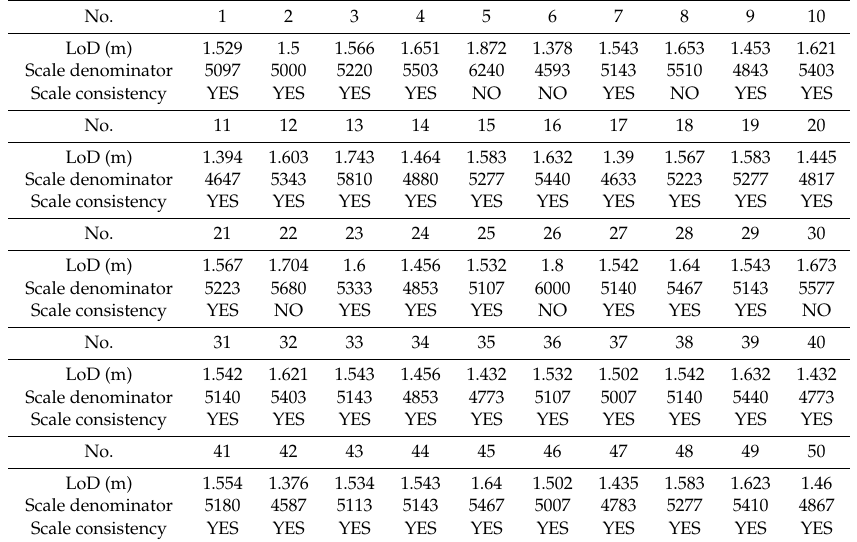
scale 1:4500. The two actual scales are both within the tolerance range of the map scales.